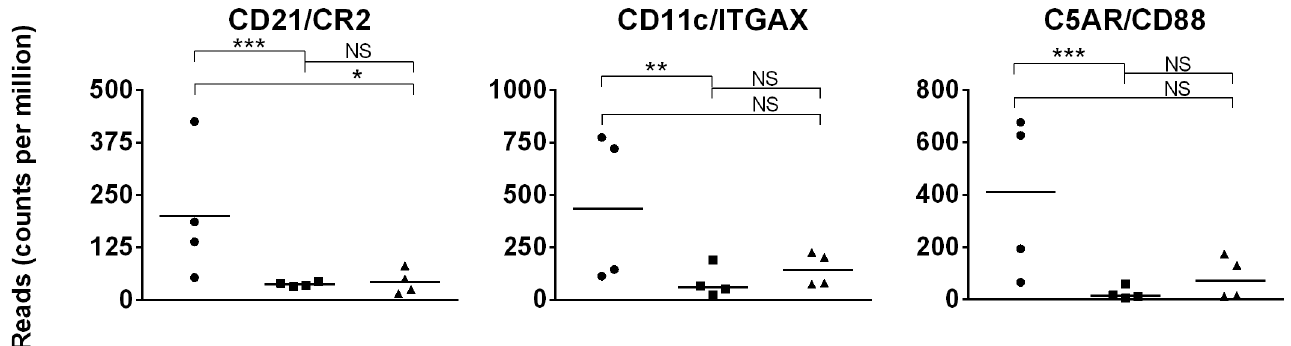
Fig 9. Complement receptor gene expression in day 1 foal, day 42 foal, and adult horse samples. Expression (quantified by number of reads on y-axis) of complement receptor genes in day 1 foal (circle), day 42 foal (square), and adult (triangle) samples are plotted on the x-axis. The significance level of comparisons is indicated by asterisks ( (cid:3) p < 0.05; (cid:3)(cid:3) p (cid:20) 0.001; (cid:3)(cid:3)(cid:3) p (cid:20) 0.0001); comparisons that did not differ statistically are labeled “NS” to denote not